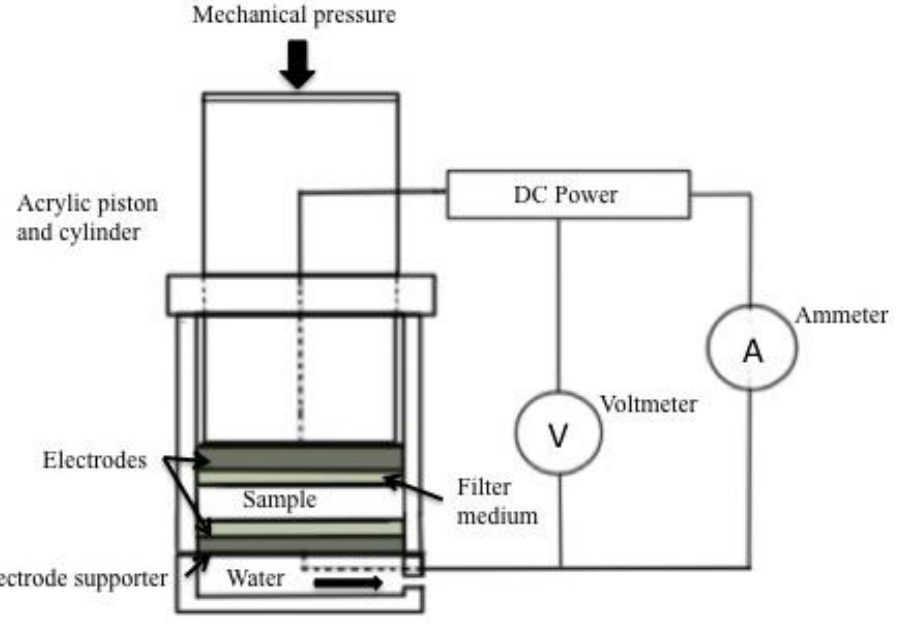
Figure 3. Pressurized electro-osmotic